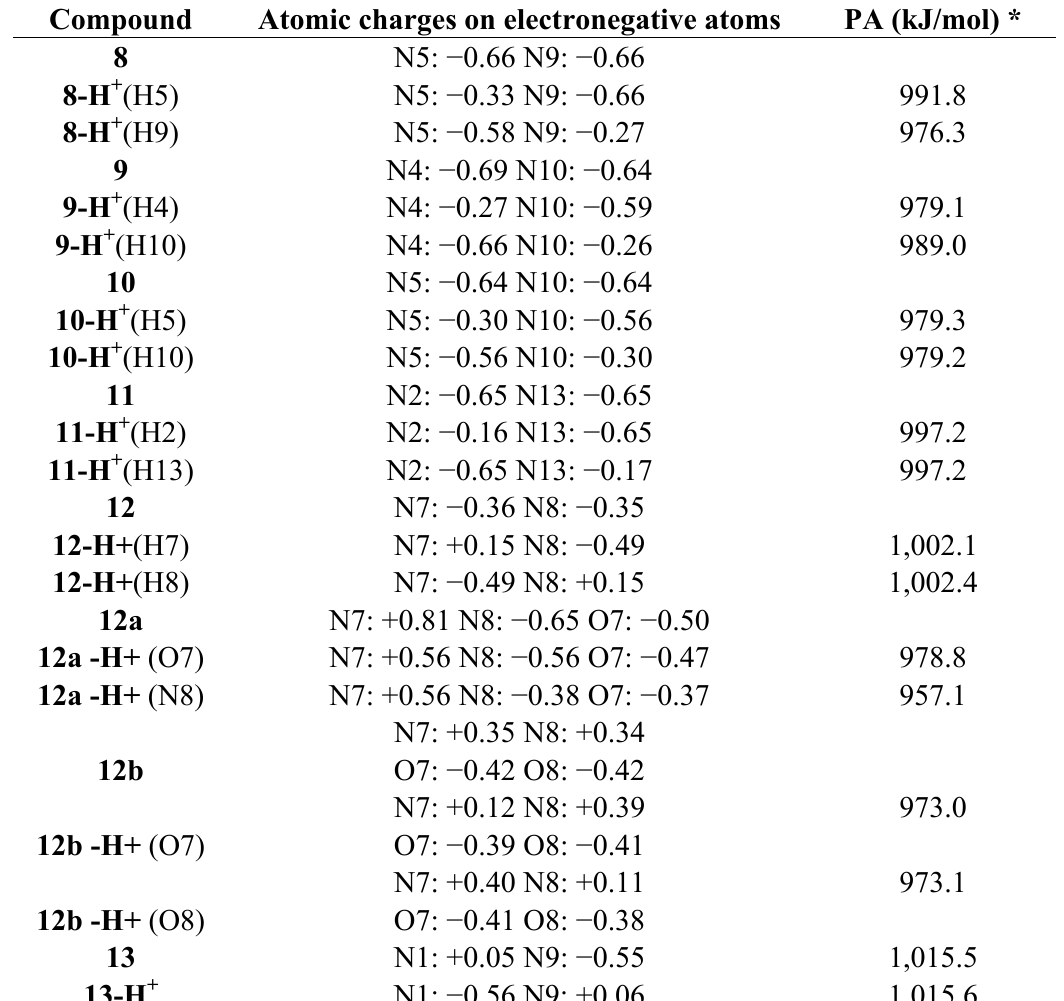
Table 2. Proton affinity values and estimated atomic charges on electronegative atoms for neutral and protonated diaza[5]helicenes calculated at the B3LYP/6-311G** level of the theory. 1,10-phenanthroline ( 13 ) was included as reference.